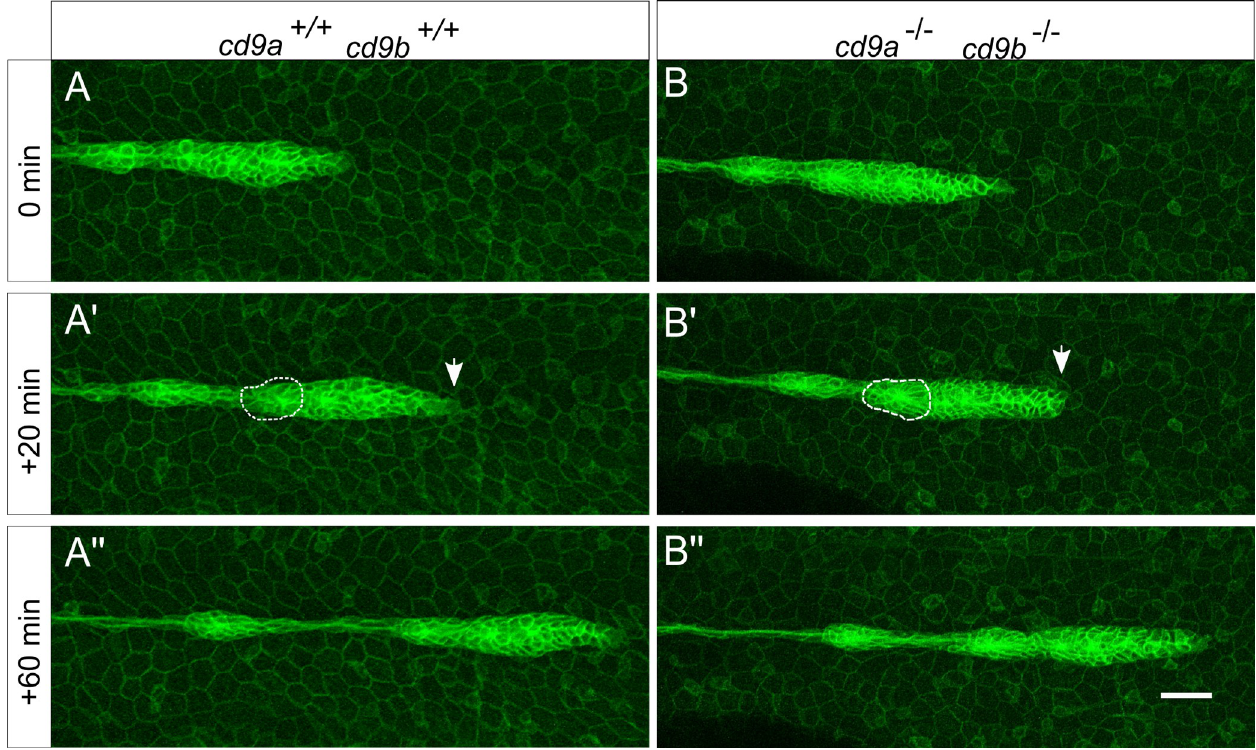
Fig 6. Primordium organisation appears normal in cd9 dKO( cldnb : gfp) embryos from 30 hpf. A-B: Still images from a time-lapse recording of a migrating primordium in (a) WT and (b) cd9 dKOs. 0 minutes shows initial deposition as a proneuromast becomes distinct from the primordium and then 2 sequential images show (a’-b’) 20 minutes and (a’’-b’’) 60 minutes later. In the primordium of both WT and cd9 dKOs, filopodia can be seen at the leading edge (white arrow) and the formation of rosettes in the trailing edge (white dashed circle). Representative images from two videos that included two depositions each. Scale bar: 20 μ